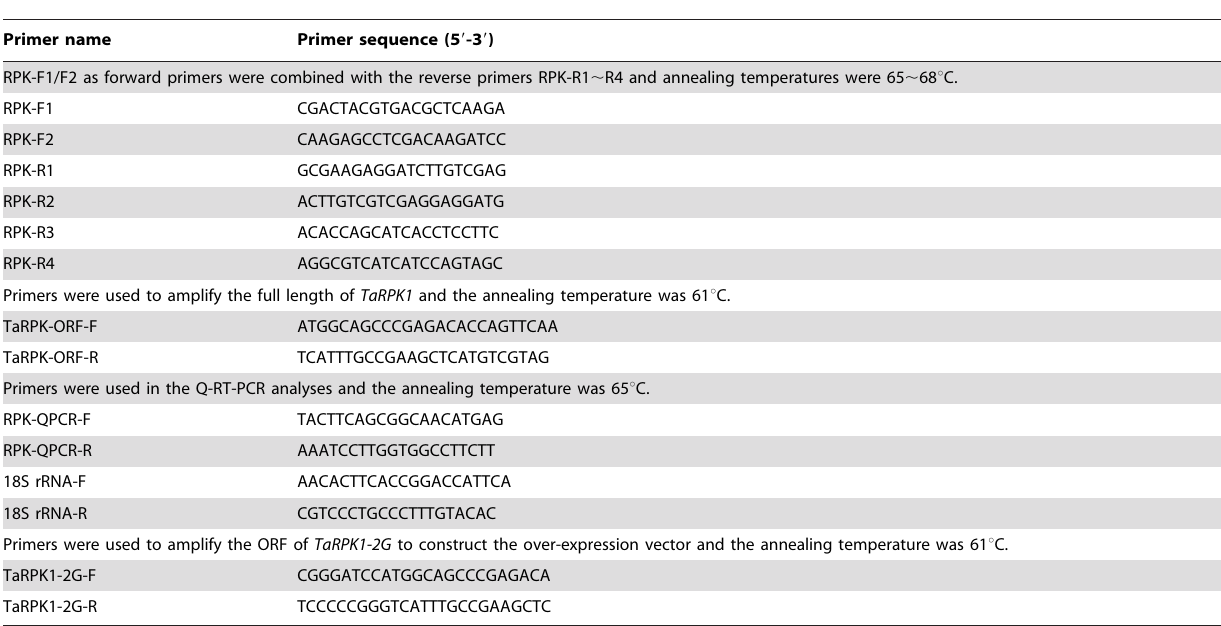
Table 2. Information of primers used in this